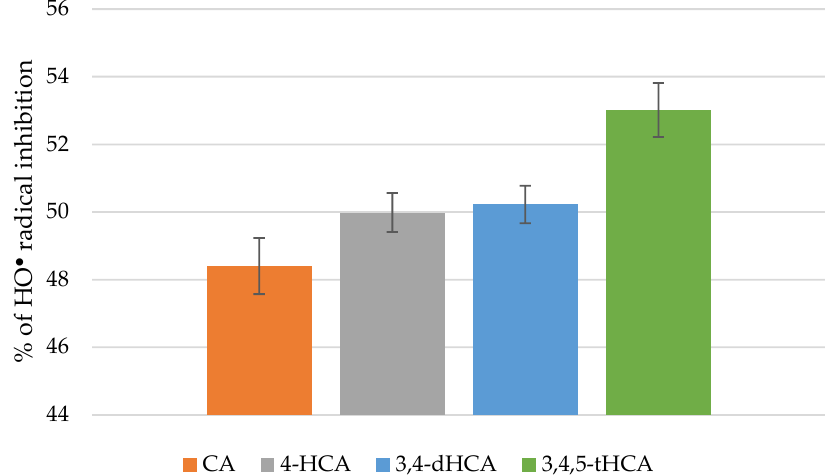
Figure 8. Antiradical activity of CA and its derivatives based on the HO ● radical assay.